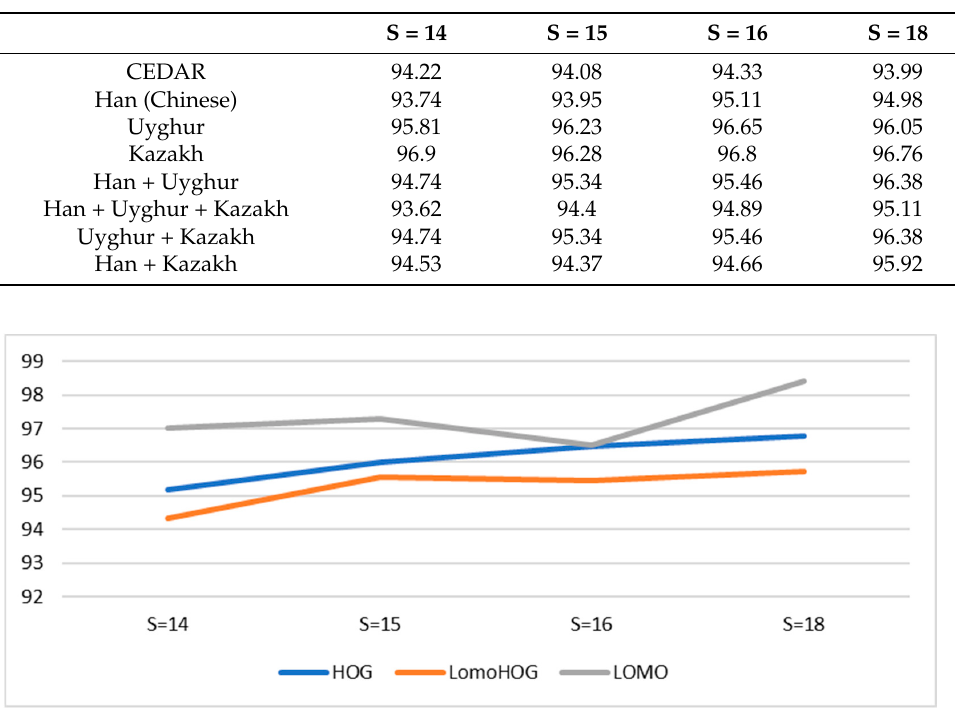
Table 6. Used the KNN classifier to identify the result after the fusion of the two features. Table 7. Comparison of recognition results of CEDAR datasets based on different features.